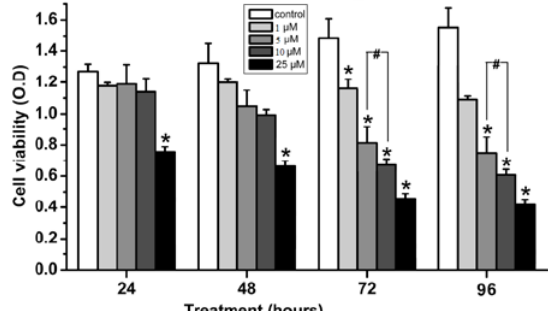
Figure 1. Scutellarein cytotoxicity on SAS cells. Cells were treated with various concentrations of scutellarein (1, 5, 10, 25 µM) and incubated for 24, 48,72 and 96 h. Scutellarin cytotoxic- ity was detected using MTT degradation assay, shown by absorbance at 490 nm. Data represent the mean ±SEM of three independent experiments. *P < 0.05 versus control, #P < 0.05 versus each